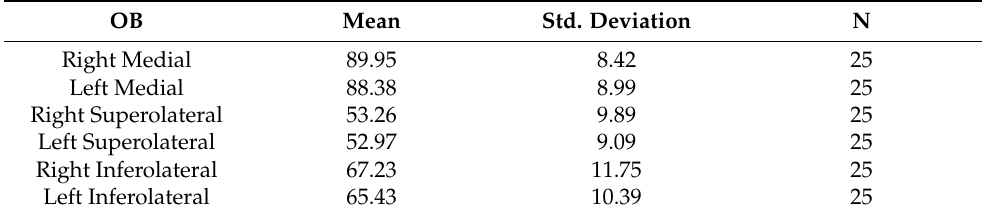
Table 6. Values of OctoBalance test in week 1.